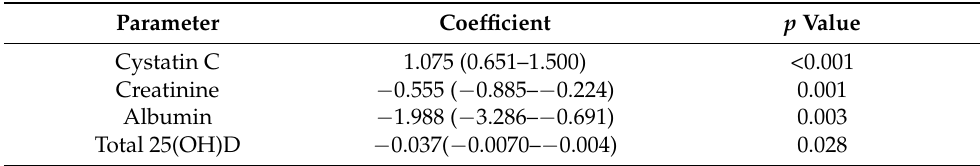
Table 4. Multiple linear regression analysis * for identifying independent predictors of BNP levels in the total CKD population.